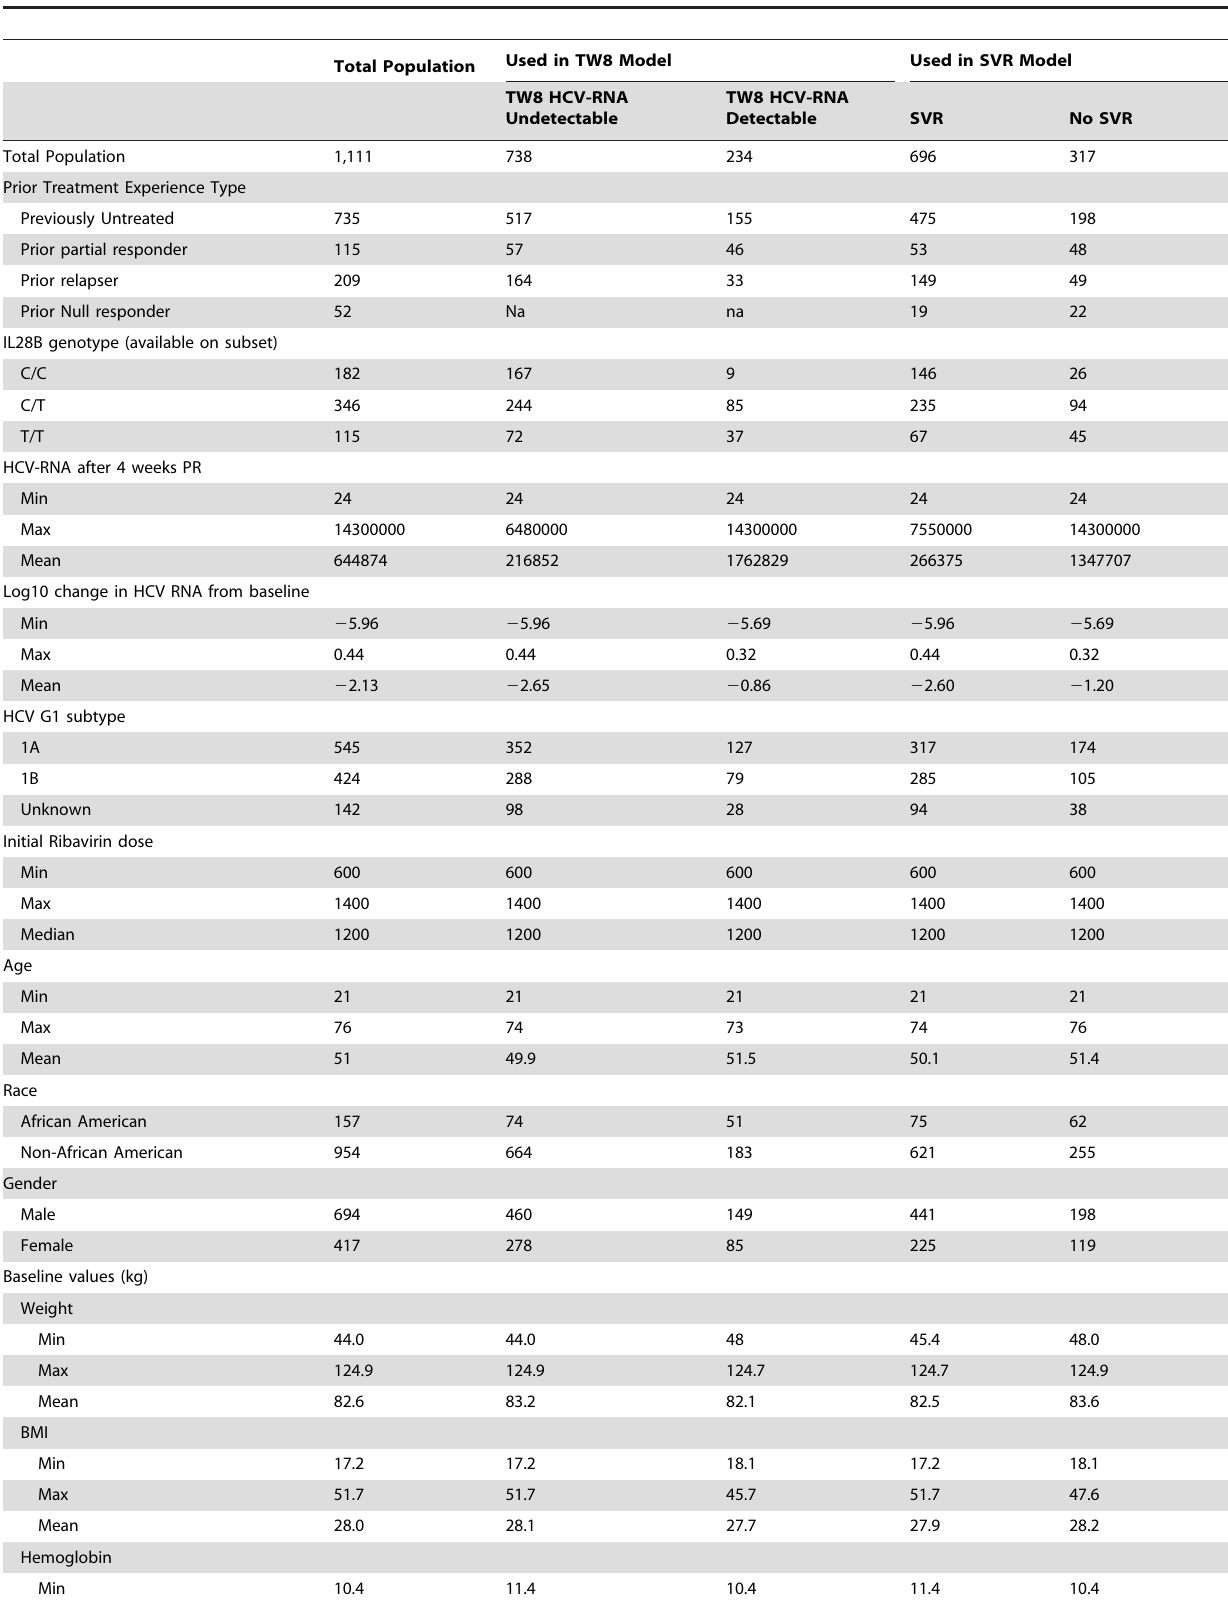
Table 1. Descriptive statistics on potential predictor variables in the total population, and patient used in the TW8 and SVR models, stratified on HCV RNA